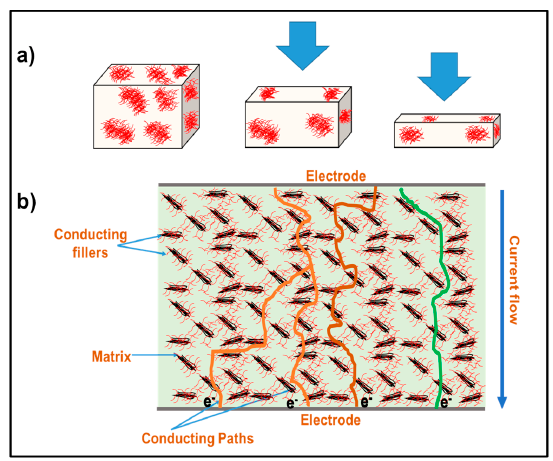
Figure 17. Schematic of: ( a ) behavior of TNL agglomerates under applied compression force, additives exhibit higher inter-distance after compression; and ( b ) conducting network formation between TNL, rGO and TNL-rGO particles.